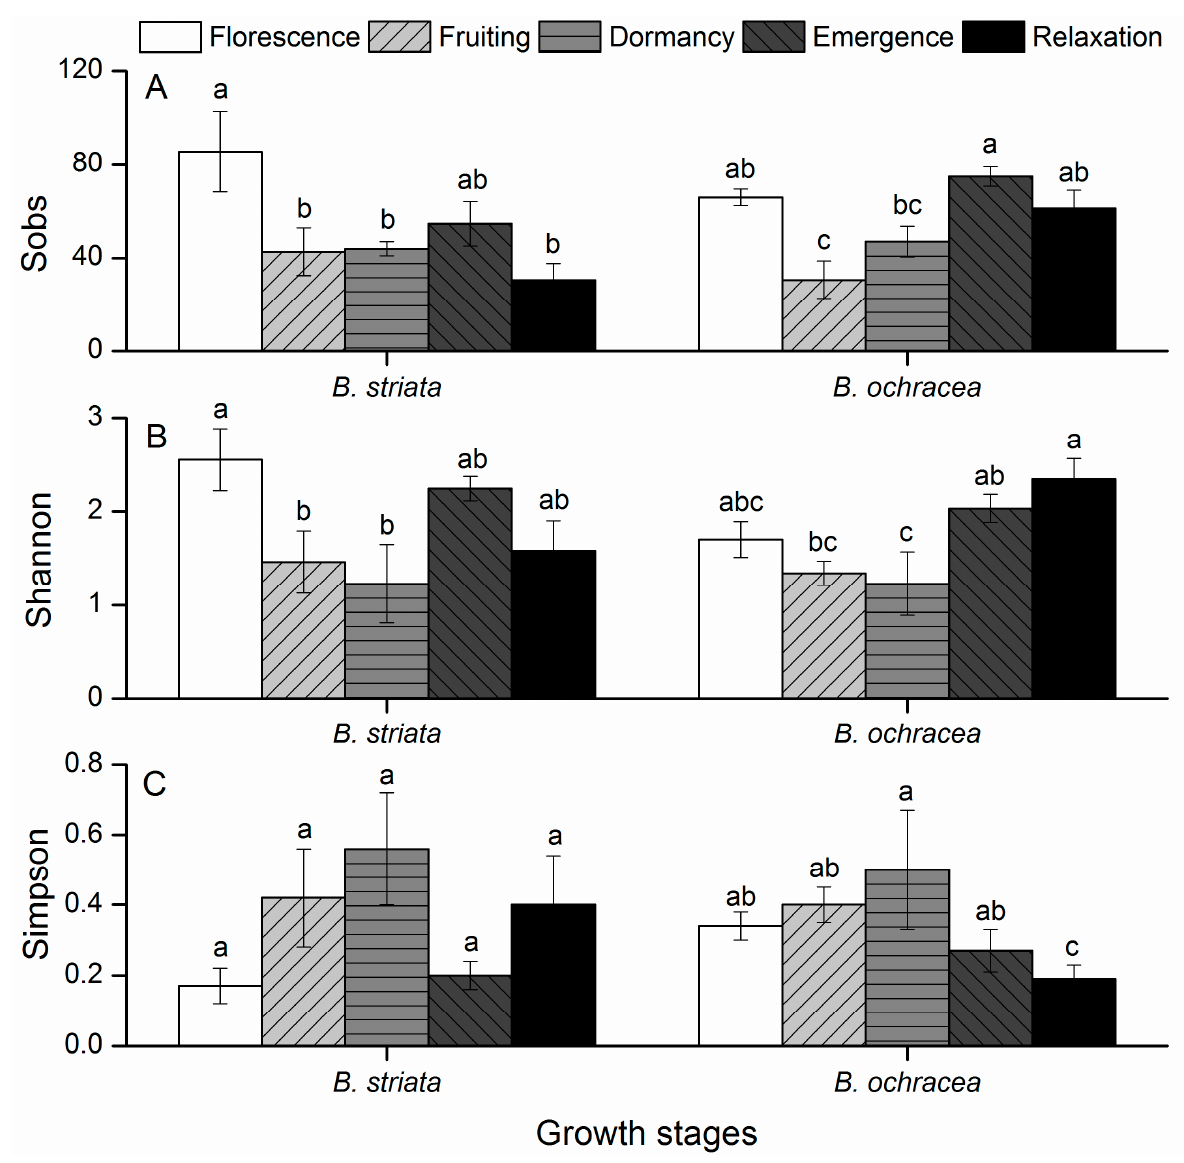
Figure 2. Alpha diversity estimates of mycorrhizal fungi associated with Bletilla striata and B . ochracea at different growth stages. Significant differences ( p < 0.05) among different growth stages of each species for each index are indicated with lowercase letters. ( A ) Sobs, ( B ) Shannon, ( C )